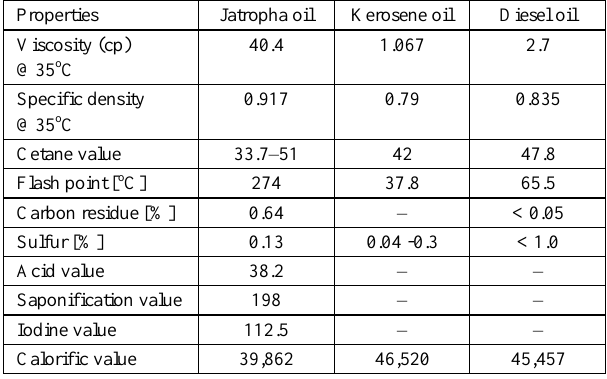
Table 3. Physico-chemical and fuel properties of jatropha curcas, kerosene, and diesel oil [13, 29]